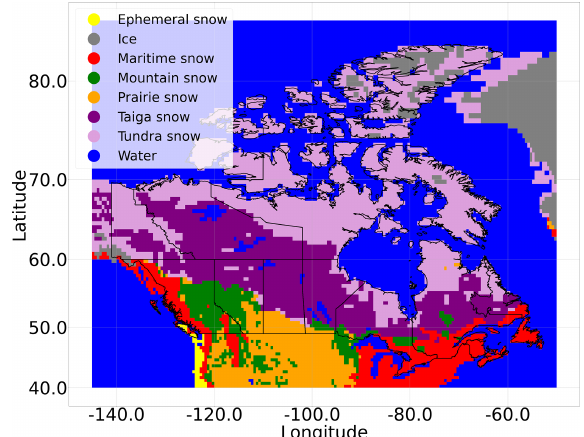
Figure 1. Snow classes across Canada as defined by Sturm et al.